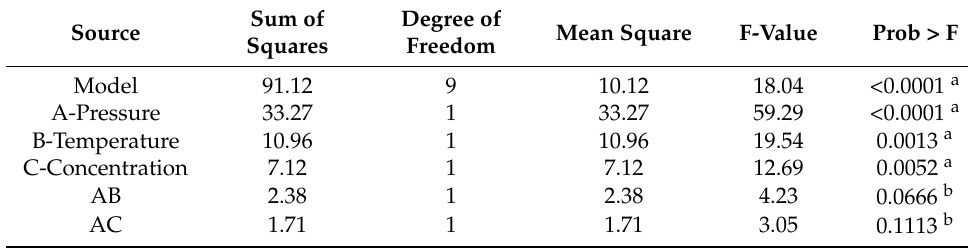
Table 5. Analysis of variance (ANOVA) for CO 2 /CH 4 separation factor.